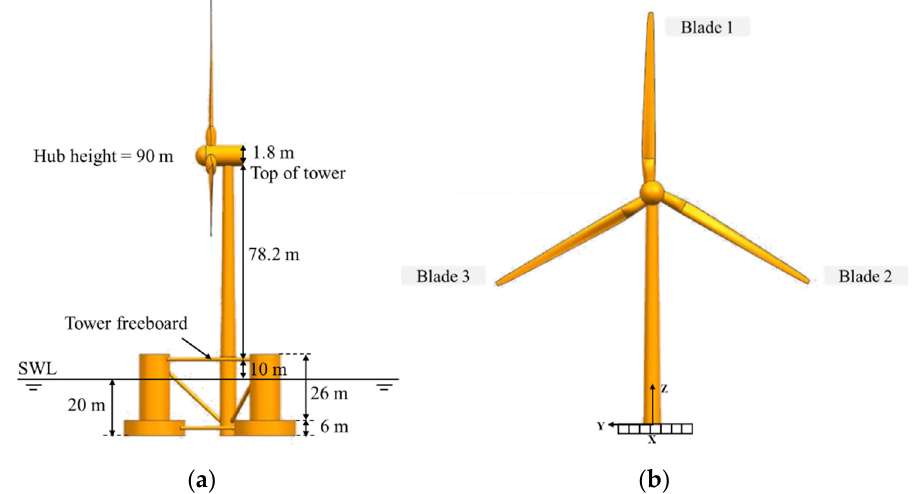
Figure 1. The track of Typhoon Mangkhut.